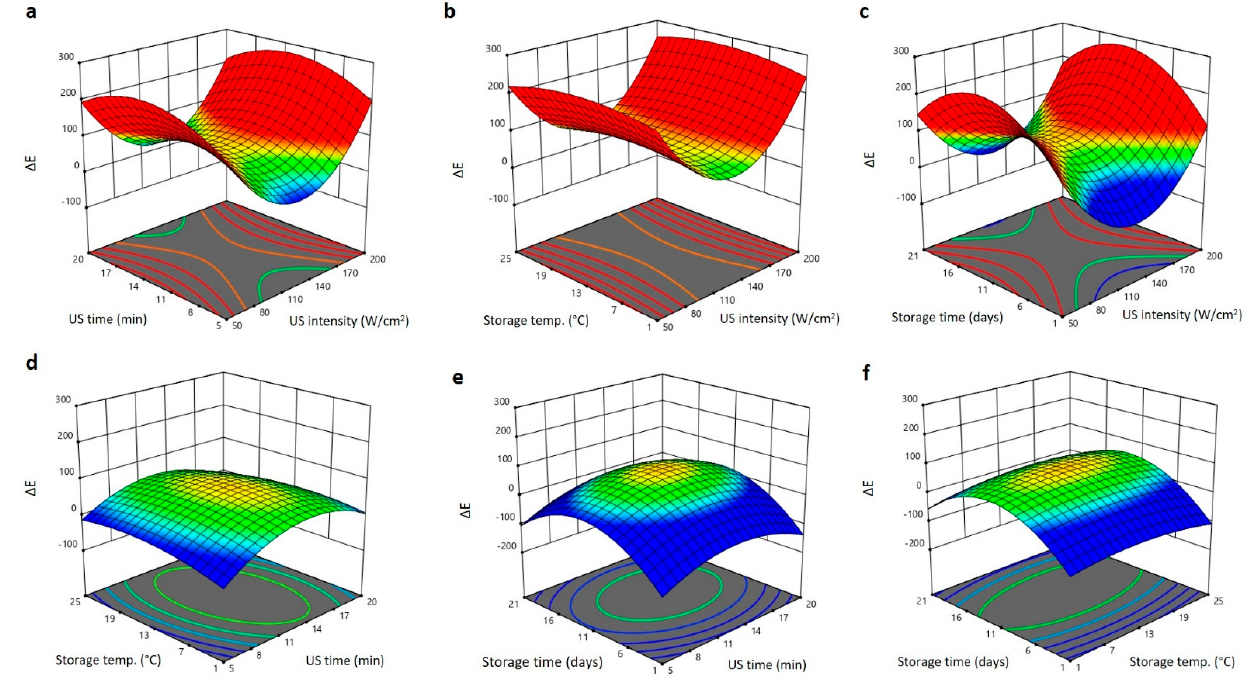
Figure 4. Response surface plots of total color changes ( Δ E) of Barhi dates as a function of US time and US intensity ( a ), storage temperature and US intensity ( b ), storage time and US intensity ( c ), storage temperature and US time ( d ), storage time and US time ( e ), and storage time and storage temperature ( f ).